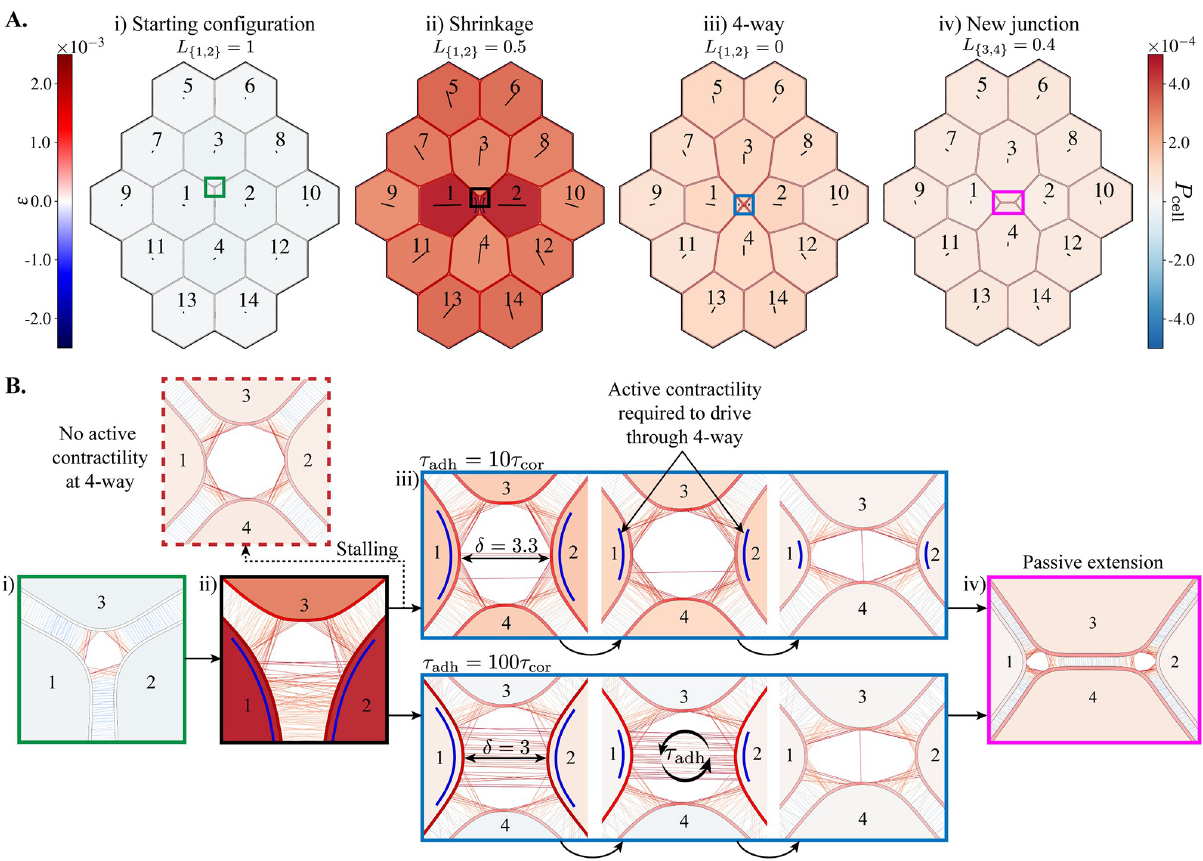
Fig 3. Simulating an active neighbour exchange. (A) Image sequence from S3 Movie, with τ adh = 10 τ cor , ( κ , ω ) = (0.01, 0.05) and active contractility ( γ = 0.94) in only the {1, 2} junction. All other cortex locations (in all cells) have a low-level pre-stress, γ 0 = 1 − 2 × 10 − 4 . Cell shading represents the magnitude of isotropic cell stress, P cell (see Eq (17) of S1 Text), and cortex shading represents the strain, ε = α − 1. Lines within cells show the principal axis of cell stress. (B) Close-ups of cell vertices from coloured boxes in A . (i) Before active contractility is applied. (ii) During junction shrinkage. The dashed arrow shows the case where the active contractility is removed before the 4-way vertex is resolved and the exchange stalls. (iii) Resolution of the 4-way vertex for two choices of the adhesion timescale. (iv) Following resolution, the new junction extends passively. Cortex locations with active contractility ( γ < 1) have been marked by blue lines next to the